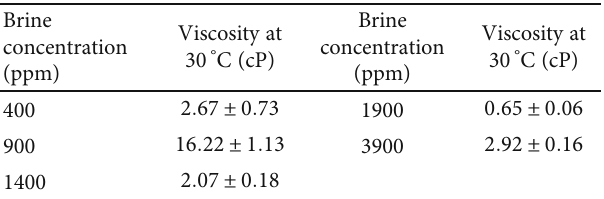
Table 4: Viscosity measurements of COP 30 w/w% AA+LA copolymer by using di ff erent brine